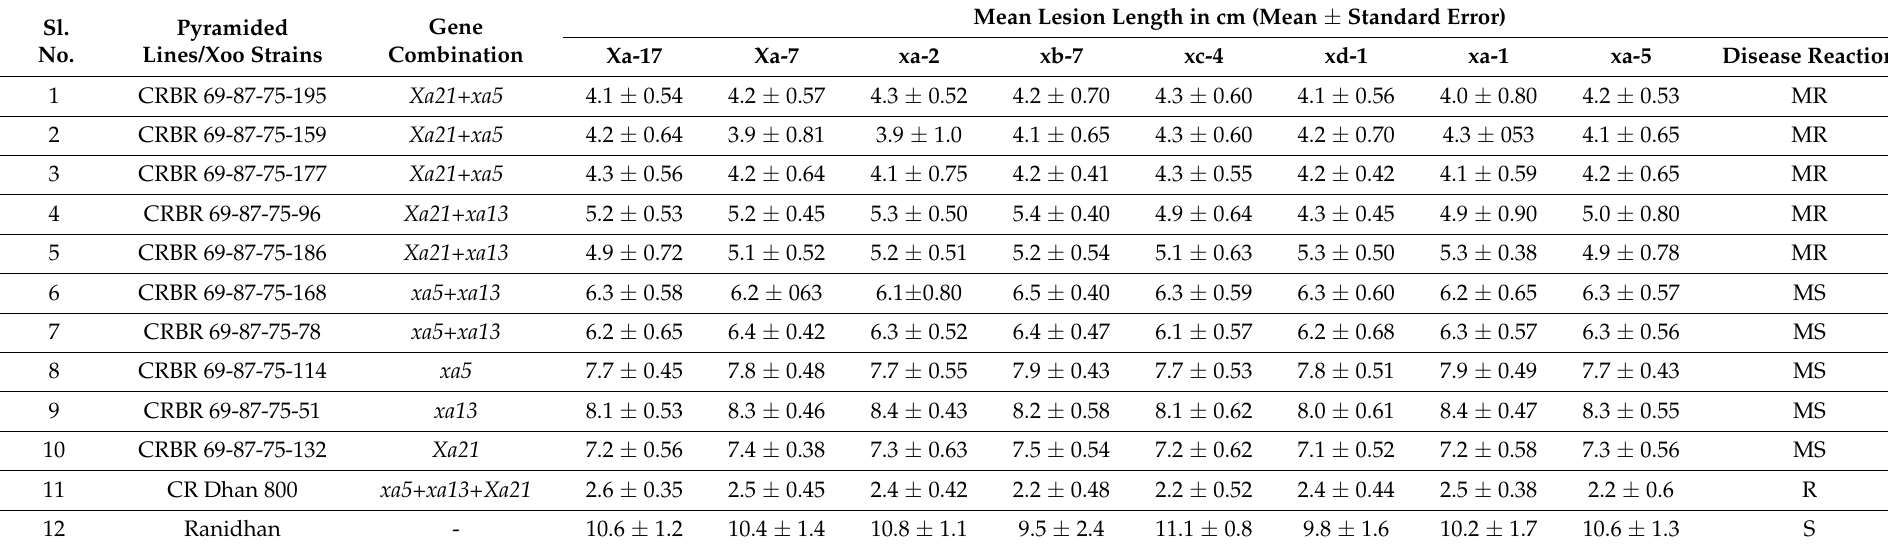
Table 2. BB disease reaction of parental, BC 3 F 3 , and BC 3 F 4 pyramided lines against different Xoo strains.